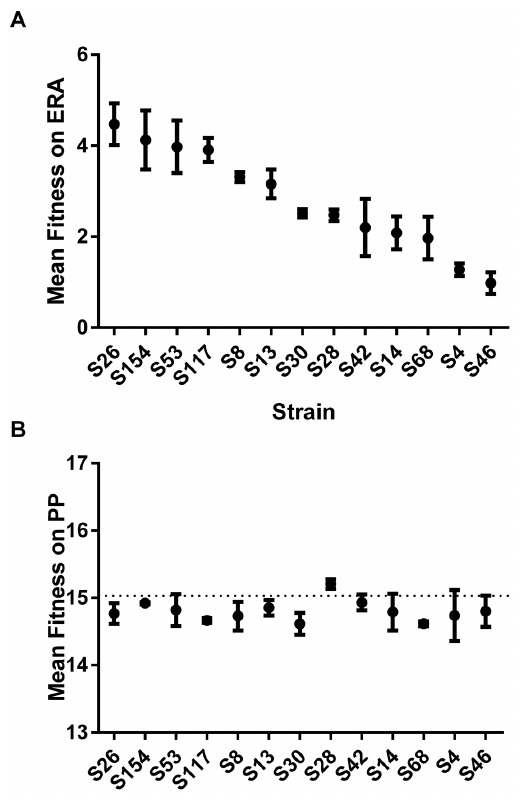
Figure 2. Mutant absolute fitness on canonical and novel hosts. Panel A: Absolute fitness of 13 6 host range mutants on the novel host, ERA. Each point is the mean of 5 replicate measurements of fitness. Bars are 6 1SE. Panel B: Absolute fitness of 13 6 host range mutants on the canonical host, PP. Each point is the mean of 5 replicate measurements of fitness. Fitness of wildtype 6 is shown by the dotted line for comparison. Bars are 6 1SE.